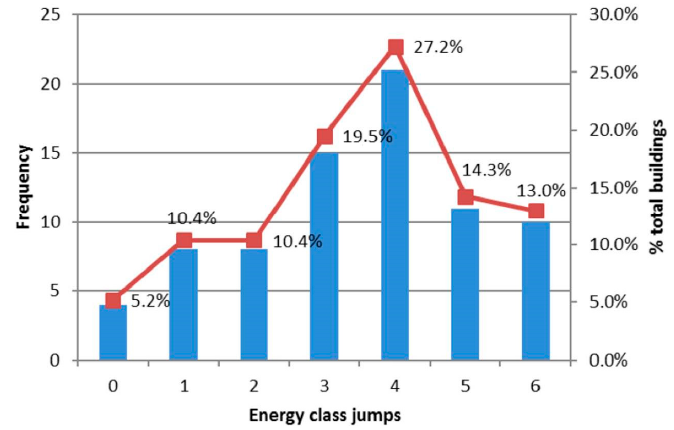
Figure 8. Frequency distribution of jumps in energy classes according to the energy retrofit projects.